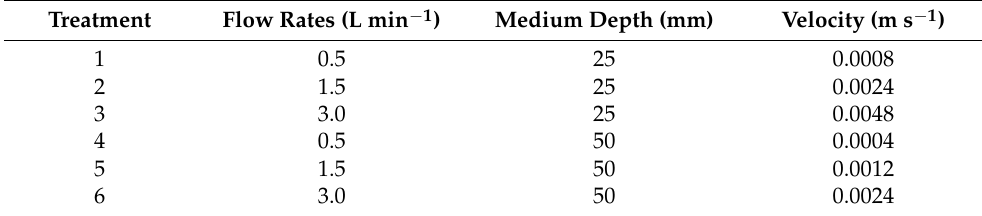
Table 1. Treatment combinations of flow rates (0.5, 1.5 or 3.0 L min − 1 ) and medium depths (25 mm or 50 mm). Calculated system velocities are